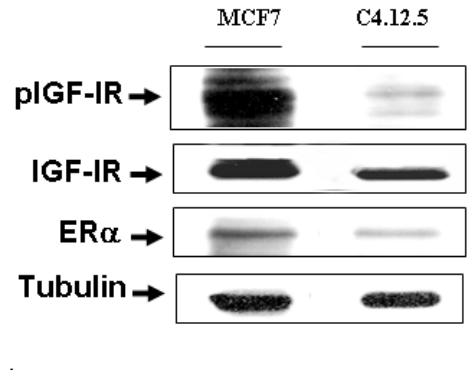
Figure 3. IGF-IR and ER  expression in MCF7 and C4.12.5 breast cancer cell